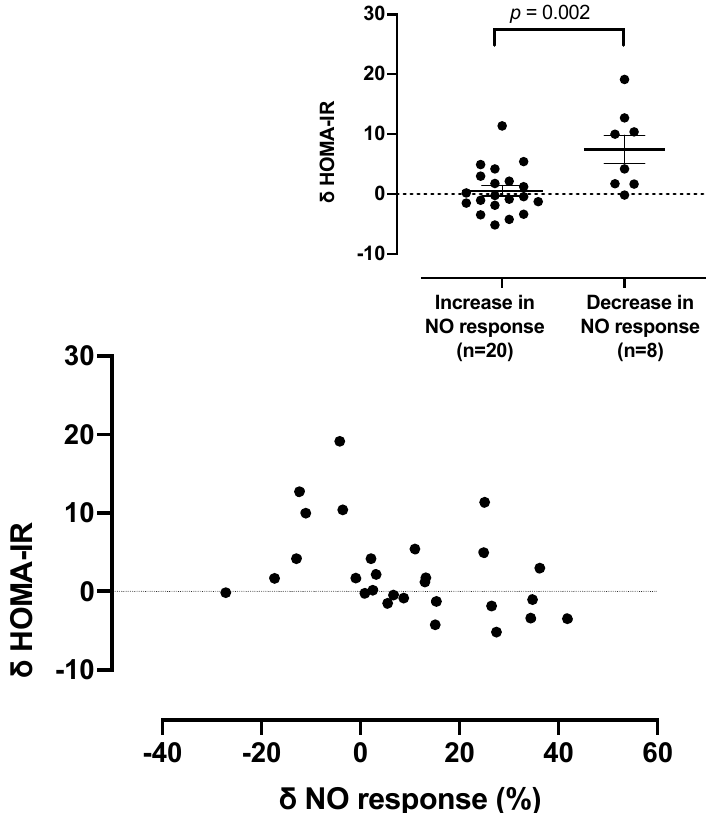
Figure 2. Correlation between changes in platelet responses to nitric oxide and in insulin sensitivity in patients treated with Px: r = − 0.304, p = 0.1. Platelet content of TXNIP and plasma concentrations of ADMA, MPO and TSP-1 did not change significantly under treatment with Px (Figure 3). Furthermore, there was no significant relationship between individual patient fluctuations in TXNIP expression changes in NO responses, and changes in HOMA-IR (data not shown).